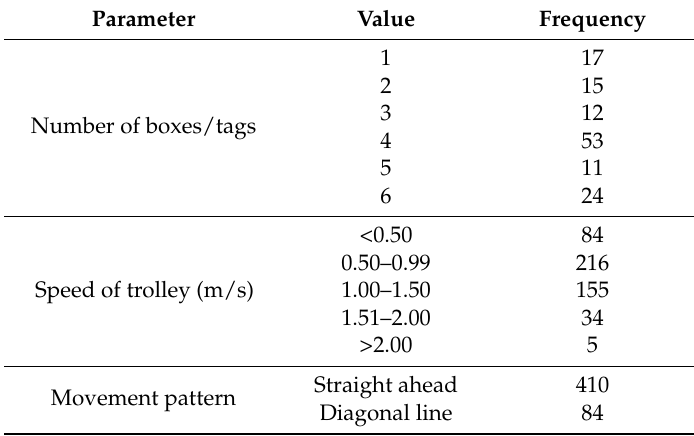
Table 2. Execution parameters for gathering the true positive